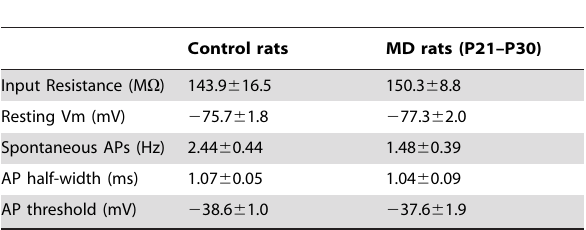
Table 1. Basic biophysical properties of